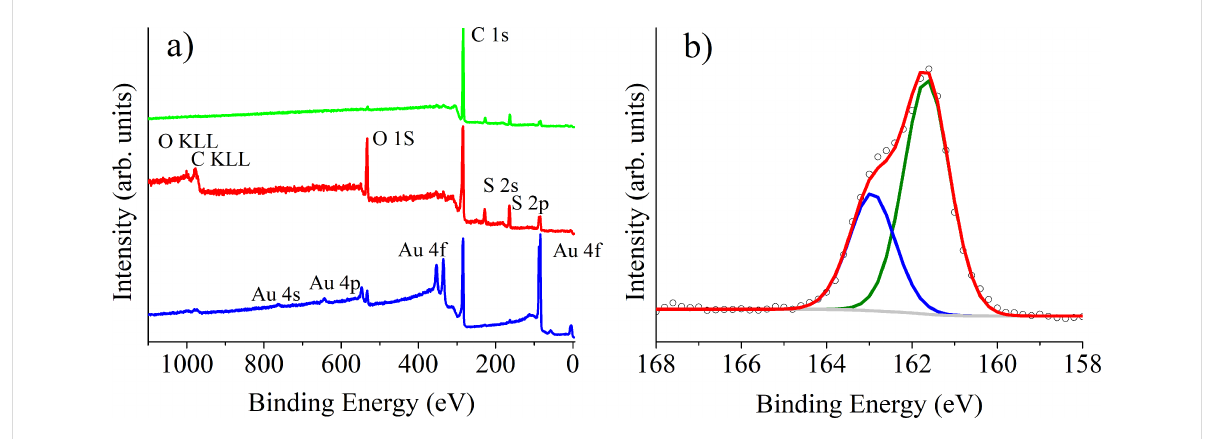
Figure 4: (a) X-ray photoelectron survey spectra recorded on Au-CNTs (blue), short-chain thiol-Au-CNTs (red) and long-chain thiol-Au-CNTs (green) samples. (b) S 2p spectrum acquired on a thiol-Au-MWCNT sample. The results for a short-chain thiol (C 3 H 8 S) are shown here, as a typical example of the SAMs